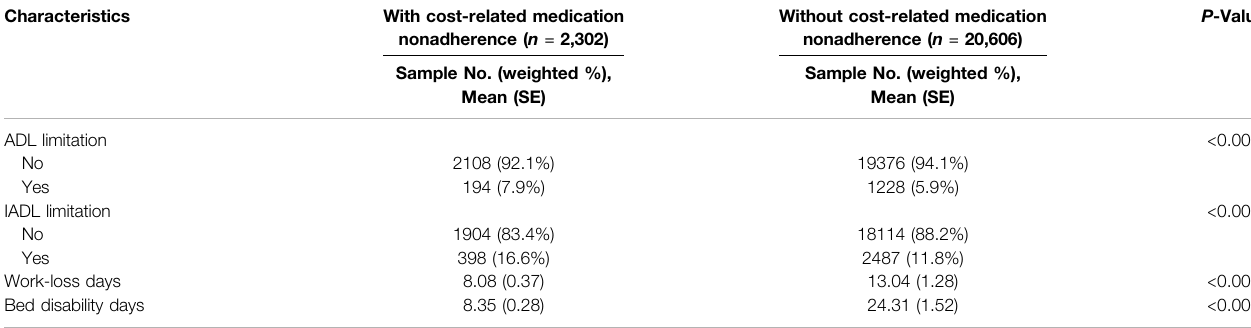
( Table 2 ). Cancer survivors with cost-related